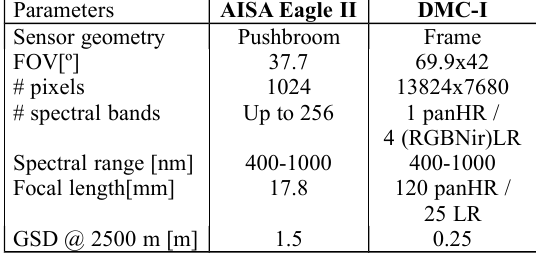
Table 1. AISA Eagle II and DMC-I main parameters.